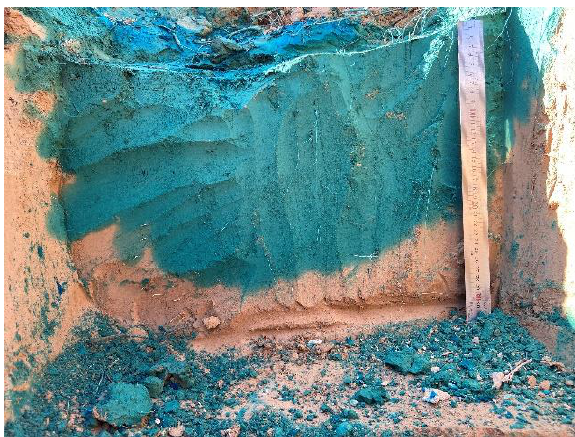
Figure 2. Photographs of the experiment.